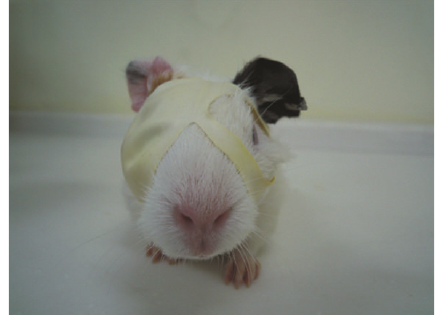
Figure 1: Form-deprived myopia in guinea pig achieved by latex